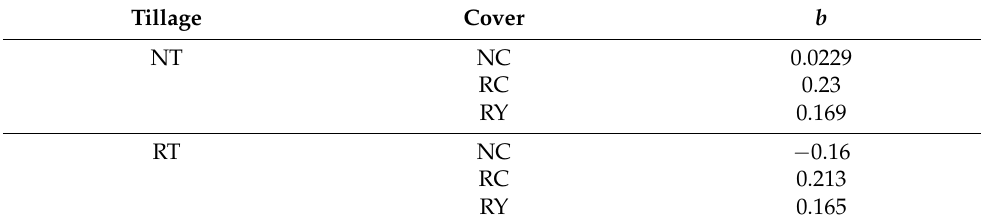
Figure 7. Directional Change of Carbon Pools. Time lag regressional analysis of composition change in carbon (C) pools on different treatment combinations treatments (NT = no-till, RT = reduced till, NC = no cover, RC = rye + clover cover crop, RY = rye cover crop). Differences in C composition are characterized by Euclidean distances, which are calculated on pair-wise C pools across the entire time series intervals (May, July, September 2019 and 2020). Plots that included a cover crop (RY and RC) showed stronger directional change than those without (NC). Positive slopes indicate that early time points of C pool composition are more dissimilar to time points further away than those closer together, a negative slope indicates that early time points are more similar to points far away than close, and a neutral slope indicates a no pattern/change in dissimilarity. Treatment plots were located in Stoneville, MS, USA. Table 2. Rate of Directional Change in C